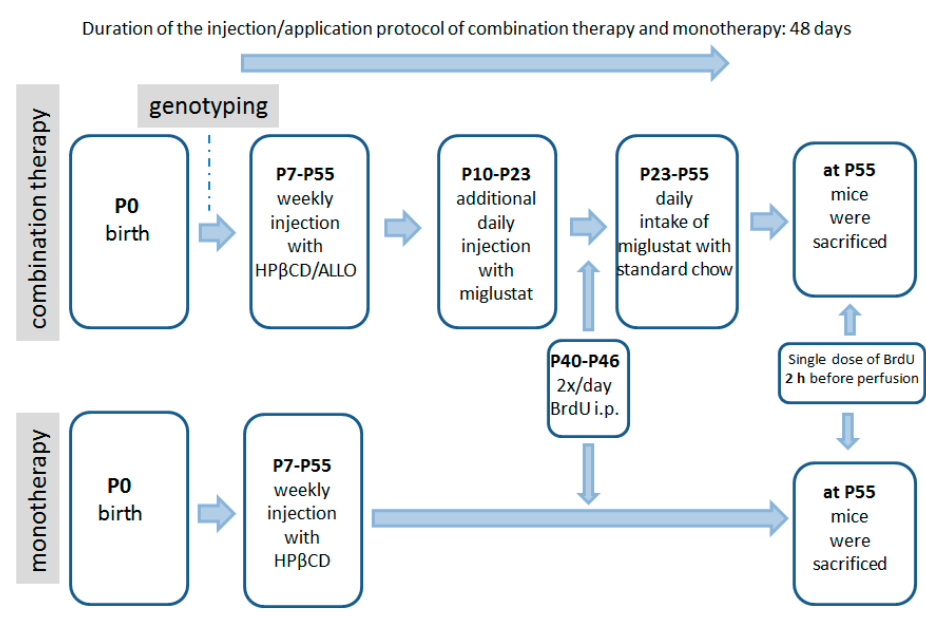
Figure 8. Scheme of the drug application for combination treatment (allopregnanolone, miglustat, HP β CD), the monotherapy with HP β CD and